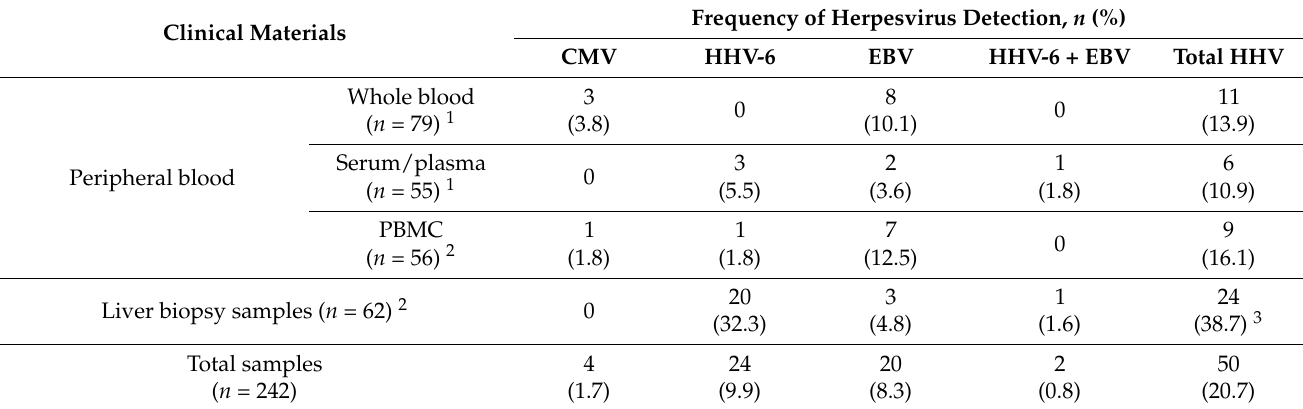
Table 2. Comparative analysis of the herpesvirus detection rates in various biological materials from patients with viral hepatitis C. Clinical